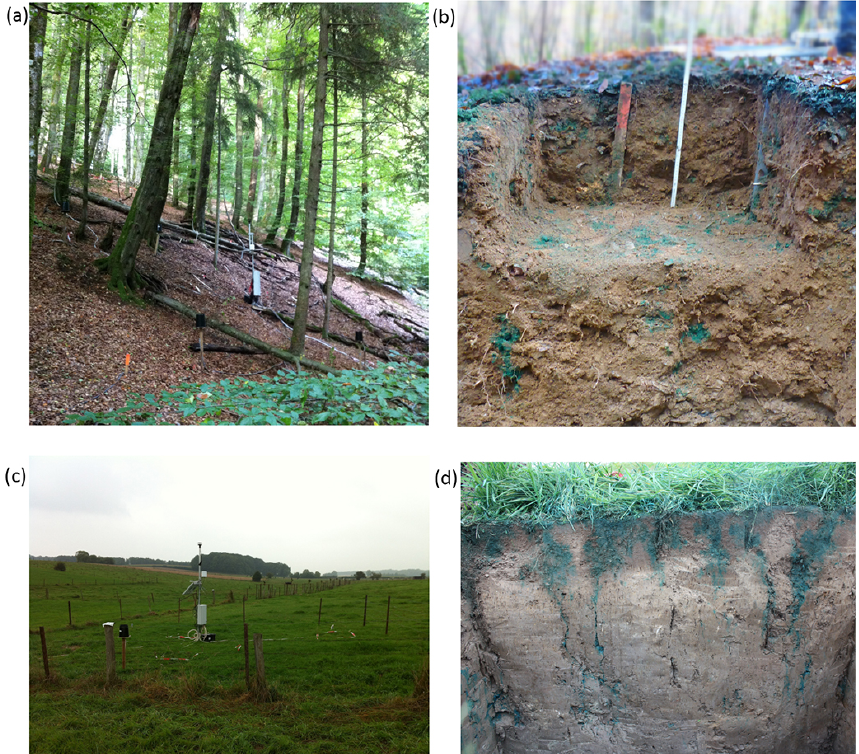
Figure 2. (a) Typical steep forested hillslope in the Colpach catchment; (b) soil profile in the Colpach catchment after a Brilliant Blue sprinkling experiment was conducted. The punctual appearance of blue color illustrates the influence of vertical structures on soil water movement in this schist area. (c) Plain pasture site of the Wollefsbach catchment; (d) soil profile in the Wollefsbach catchment after a Brilliant Blue experiment showing the influence of soil cracks and vertical structures on the soil water movement.